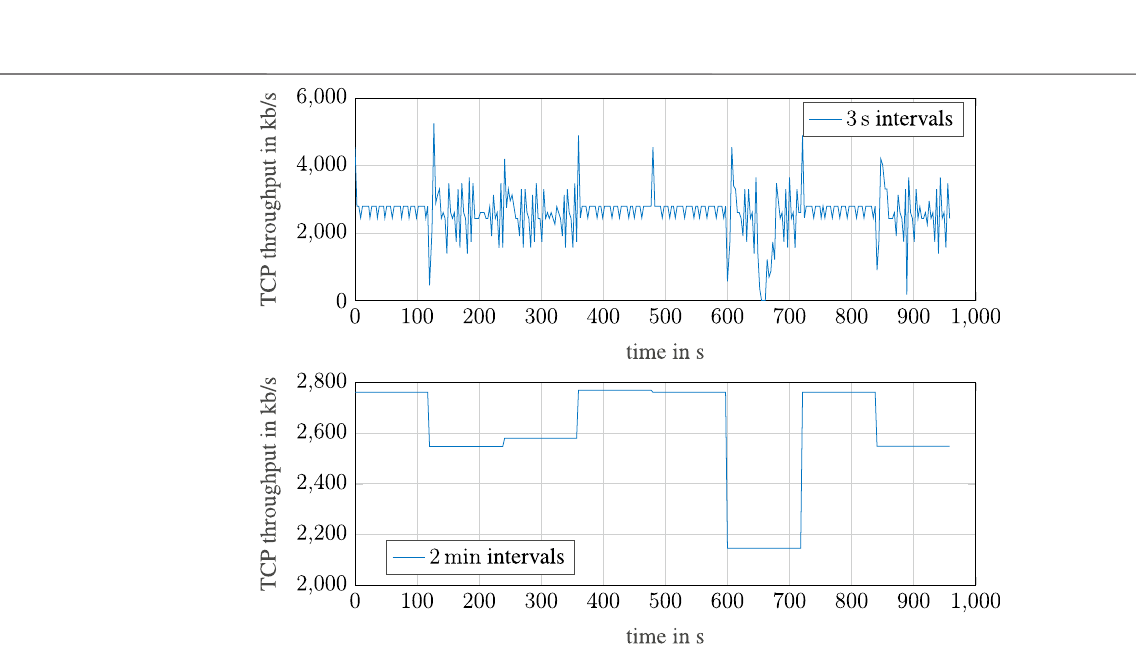
FIGURE 5 | TCP throughput measurements on the return link (static